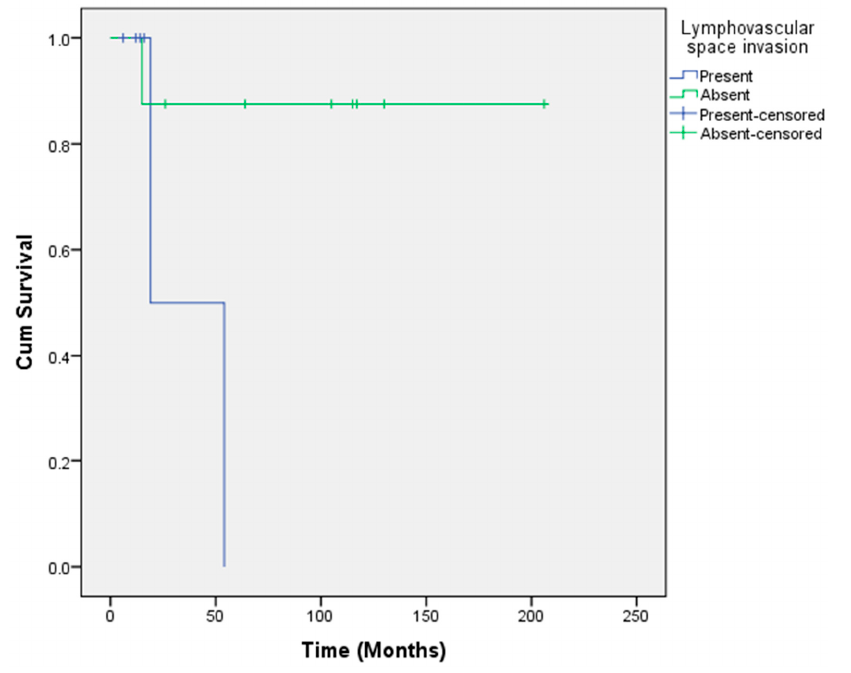
Figure 1. Lymphovascular space invasion was a predictor of survival in the primary surgery group with the presence of lymphovascular space invasion associated with worse prognosis ( p = 0.05). The mean overall survival among women with perineural invasion was 91.7 months in comparison to 153.2 months when perineural invasion was absent, but this was not statistically significant ( p = 0.772). The overall 1-, 2- and 5-year survival rates were 100%, 80.8% and 69.3%, respectively (Figure 2). All patients who survived beyond five years in our study group were still alive at 10 years (Table 1).